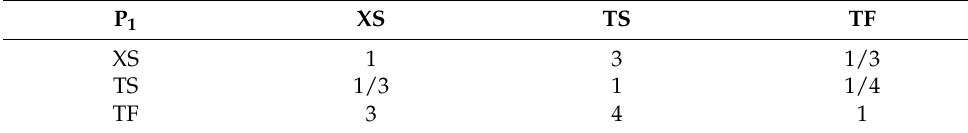
Table 3. Pairwise comparison matrix of index